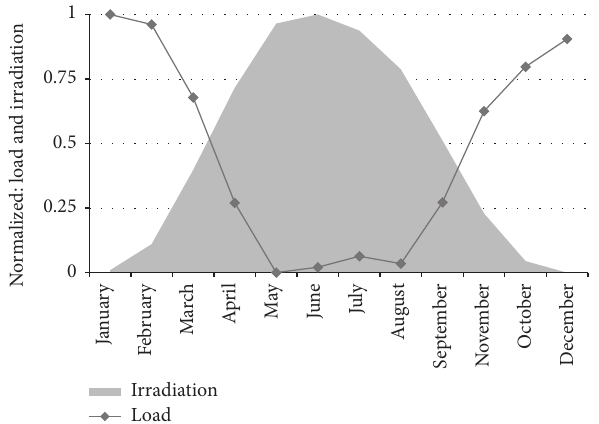
Figure 5: Normalized mean monthly values of irradiation and load in Poland over the years